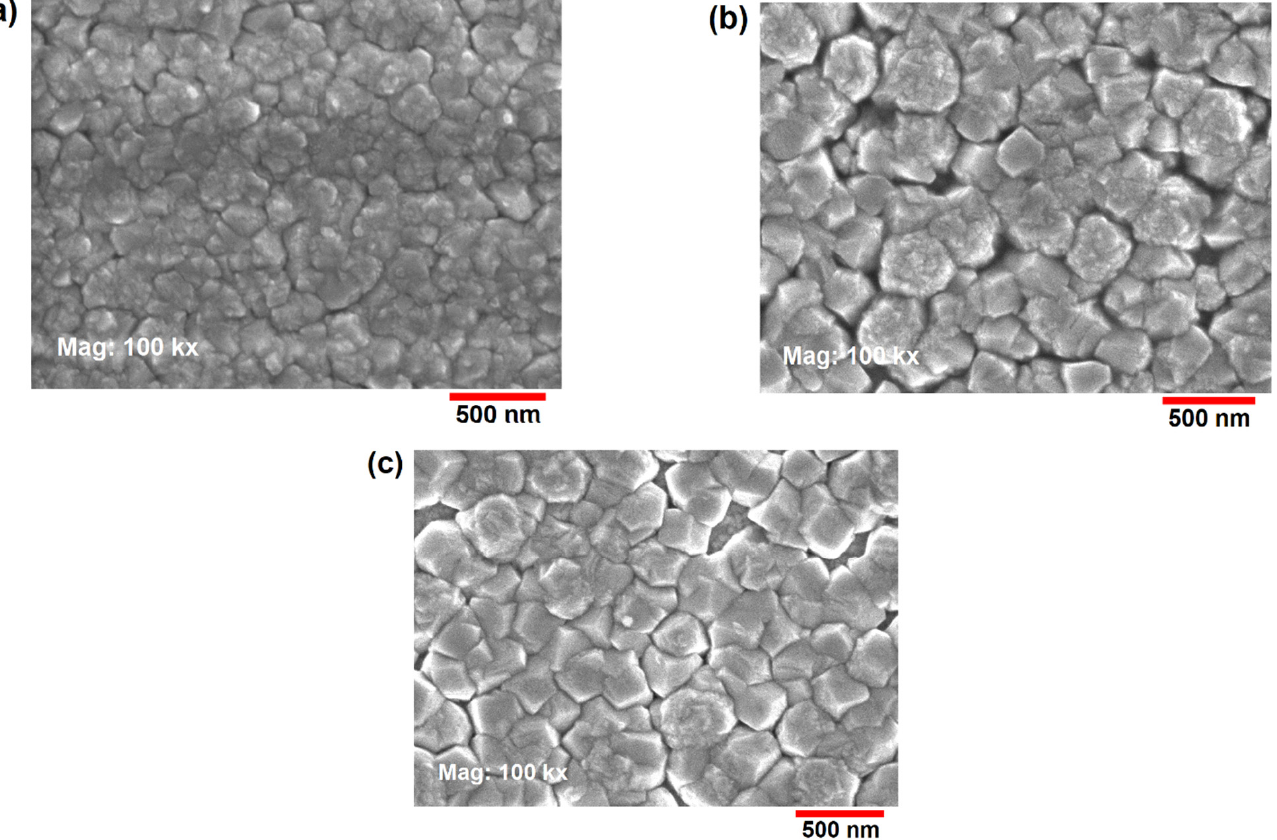
Figure 5. SEM images of the samples Fe–Co 33 –Ni 62 ( a ), Fe–Co 43 –Ni 53 ( b ), and Fe–Co 61 –Ni 36 ( c ), respectively. Figure 5a showed that the Fe–Co 33 –Ni 62 sample exhibits a surface topography com- prising only cauliflower–like agglomerates.